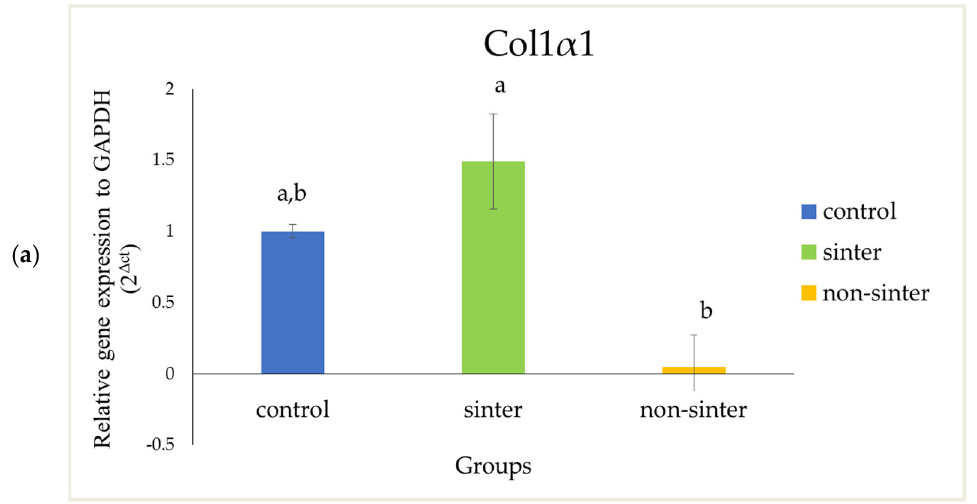
Figure 5. Alkaline phosphatase (ALP) activity of MC3T3-E1 preosteoblast cells seeded on sinter and nonsinter hydroxyapatite scaffolds. Cells without a scaffold were considered to be the control group. Same letter of a, b, c in each incubation day denotes significant differences within group ( p <